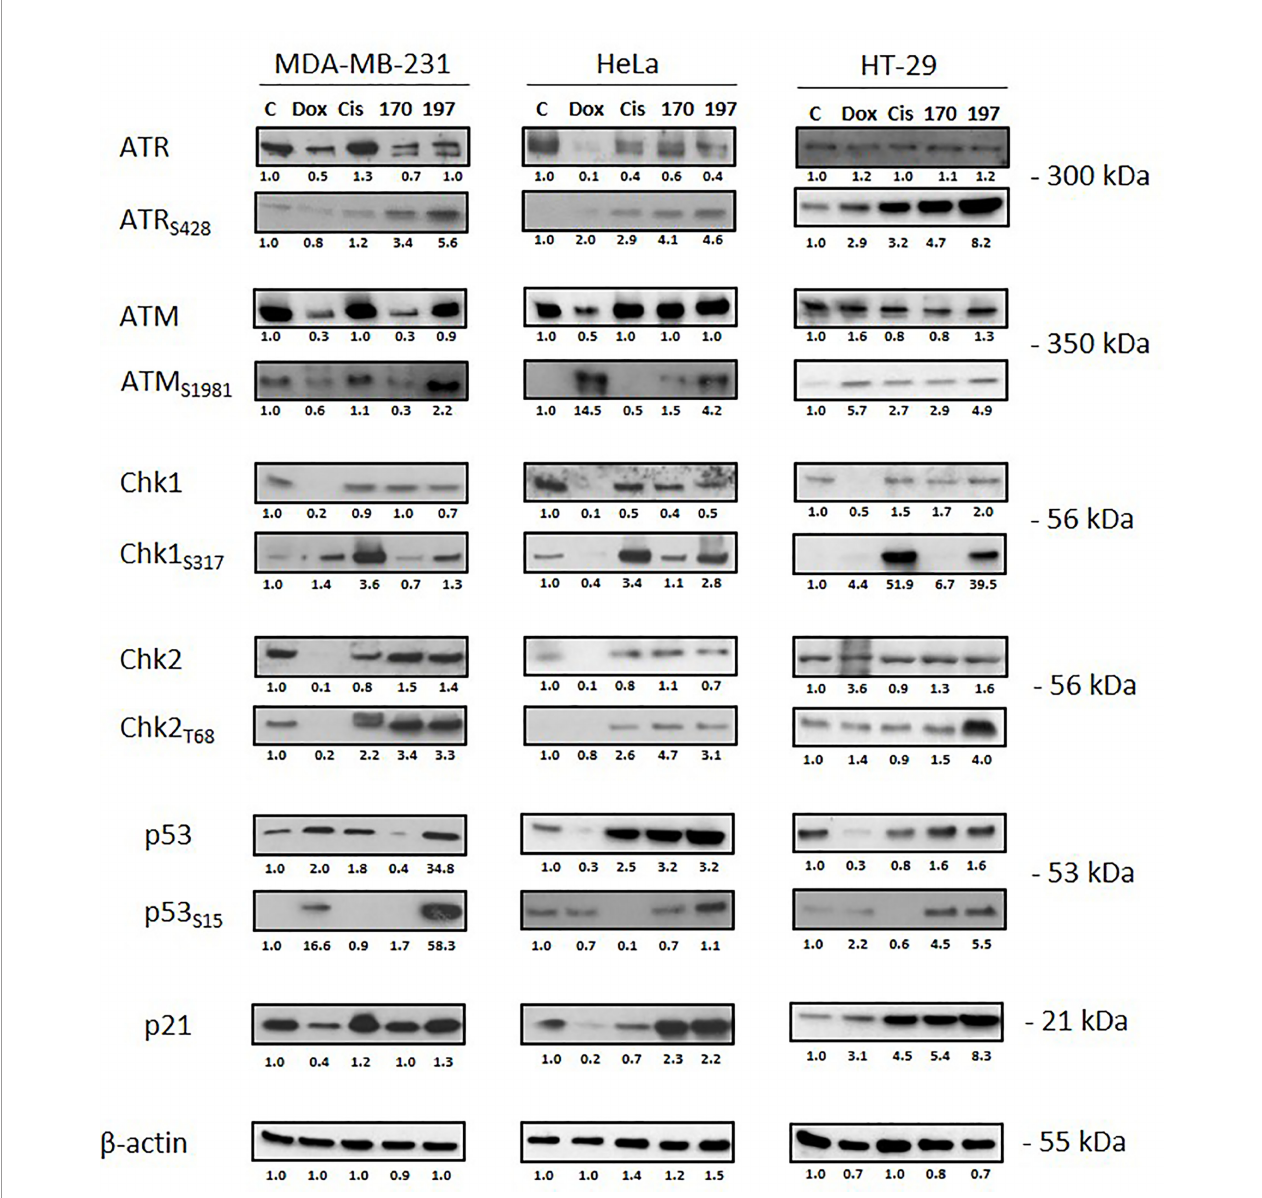
FIGURE 4 | Activation of the DNA Damage Response (DDR) pathway. Cells were treated for 24 h with doxorubicin (5 µM), cisplatin (20 µM), WN170 (0.5 µM), or WN197 (0.5 µM). Western blots were performed to detect ATM, ATR, Chk1, Chk2, p53 and their phosphorylated forms, and p21. b -actin was used as a loading control and relative protein levels were quanti fi ed by densitometry using Image J software (Fiji Software, v1.52i). Results were representative of three independent